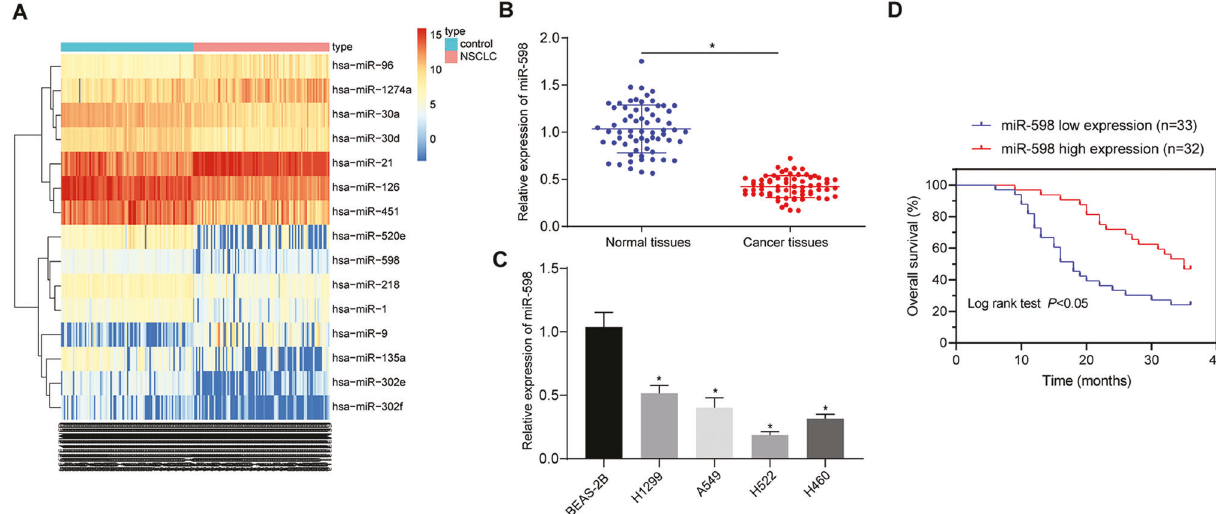
Fig. 1 Expression of miR-598 in NSCLC and its correlation with patients ’ prognosis. A Heat map of the GSE102286 dataset; the ordinate indicates the name of the differential gene, the histogram at the upper right is the color scale, and the color changes from top to bottom indicate the expression value in the dataset data from large to small; each rectangle in the graph corresponds to the expression value of a sample, and each column represents the expression level of all genes in each sample; the left dendrogram represents the cluster analysis results of different genes from different samples; the top bar represents the sample type, and the box at the upper right represents the sample color reference, in which, blue is the normal control sample, while red is the tumor sample. B Expression of miR-598 in the tumor and adjacent normal tissues of NSCLC patients by RT-qPCR; n = 65; * p < 0.05 vs. adjacent normal tissues. C Expression of miR-598 in four NSCLC cell lines (H1299, A549, H522, and H460) and one non-tumorigenic bronchial epithelium BEAS-2B cell line by RT-qPCR; * p < 0.05 vs. BEAS-2B cell line. D Correlation between miR-598 expression and prognosis of NSCLC patients by Kaplan-Meier survival analysis. Data between the tumor tissues and adjacent normal tissues were compared by paired t test. Data among mul t iple groups were compared by ANOVA with Tukey ’ s post hoc test. Cell experiments were repeated three